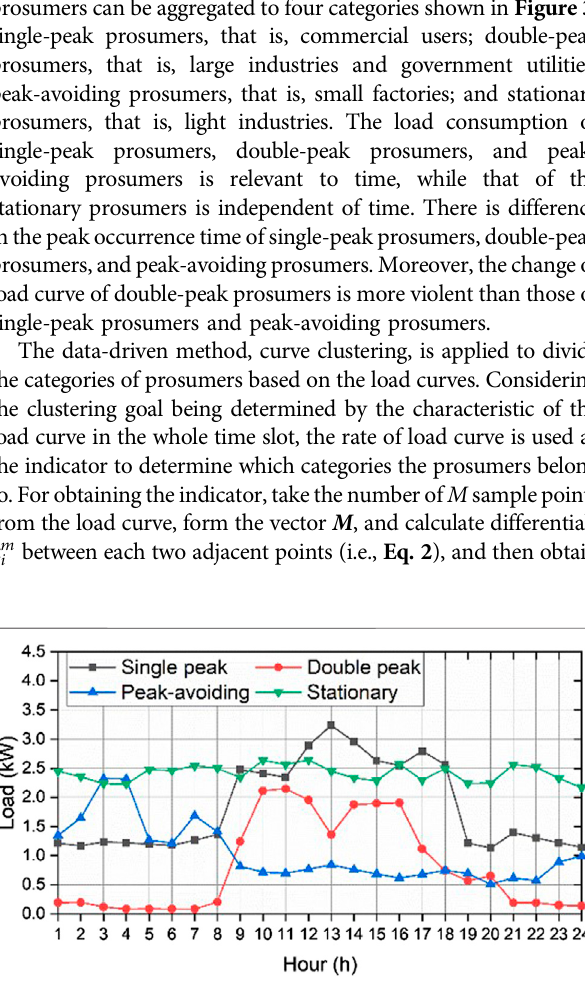
FIGURE 3 | Load curves of four different